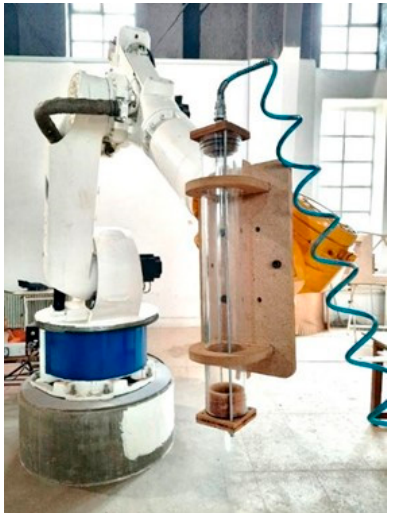
Figure 8. The Fabricated Extruder (Image credit: